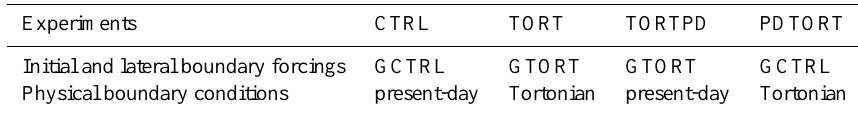
Table 2. Summary of the regional model